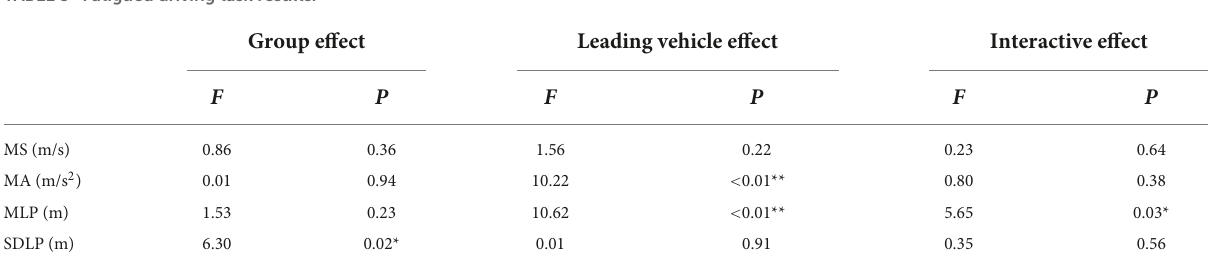
TABLE 3 Fatigued driving task